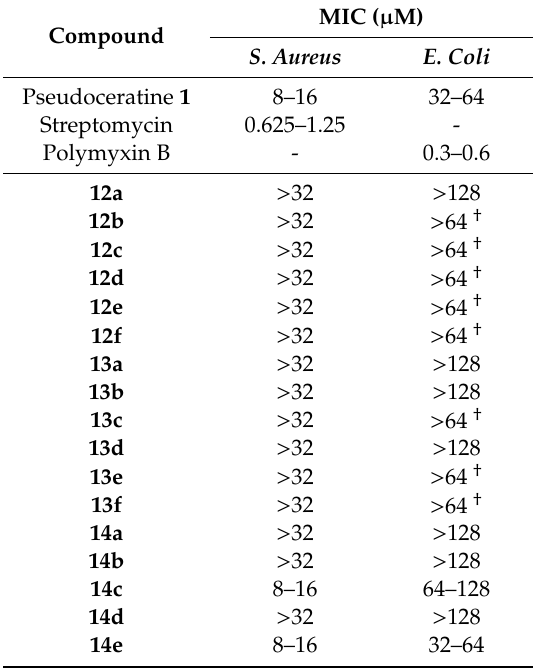
Table 2. Antibacterial activity of all synthesised analogues in comparison to standard antibiotics.